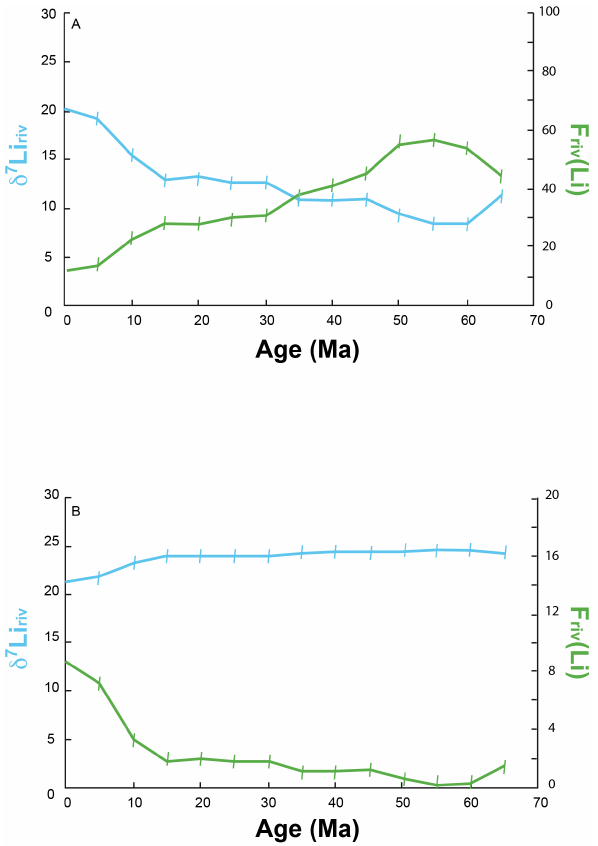
Figure 3. The two solutions of the model described in the text that can both explain the seawater record (see Eqs. (3–12), and Table 2) F riv is in 10 9 molyr − 1 (in green). (a) This solution is consistent with calculations performed by Misra and Froelich (2012) since low δ 7 Li values are found for 60Ma rivers which then increased as a function of time (in blue). (b) A second solution is also possible, using exactly the same set of parameters. In this case, river δ 7 Li has decreased as a function of time while the Li river flux has